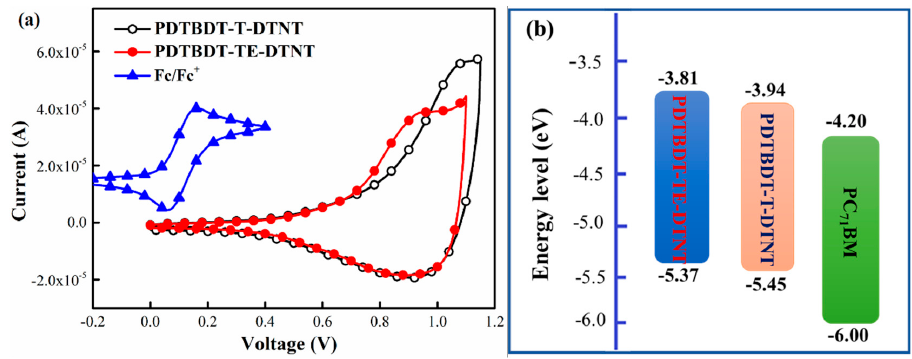
Figure 4. Cyclic voltammetry curves ( a ) and energy levels schematic diagram ( b ) of copolymers.